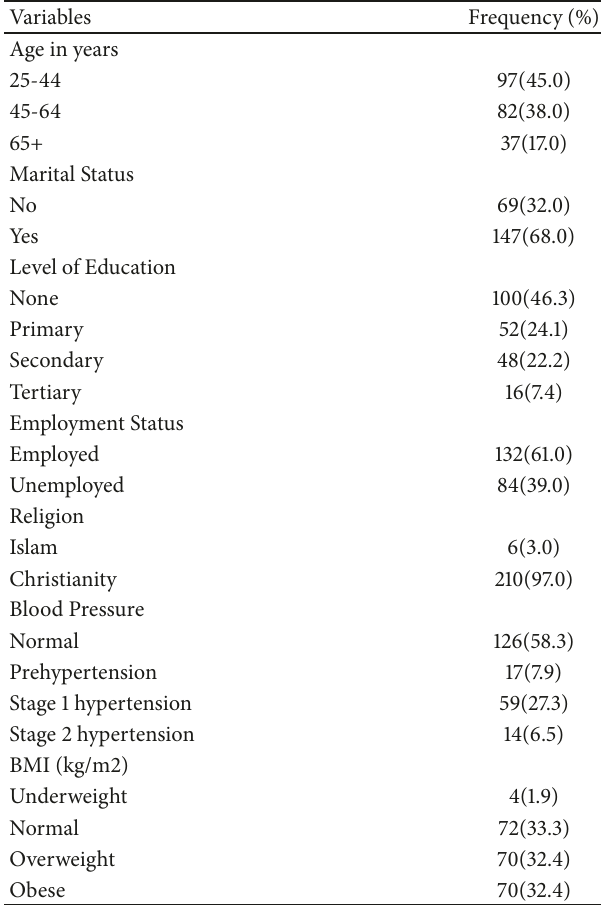
Table 1: The background characteristics of the study subjects